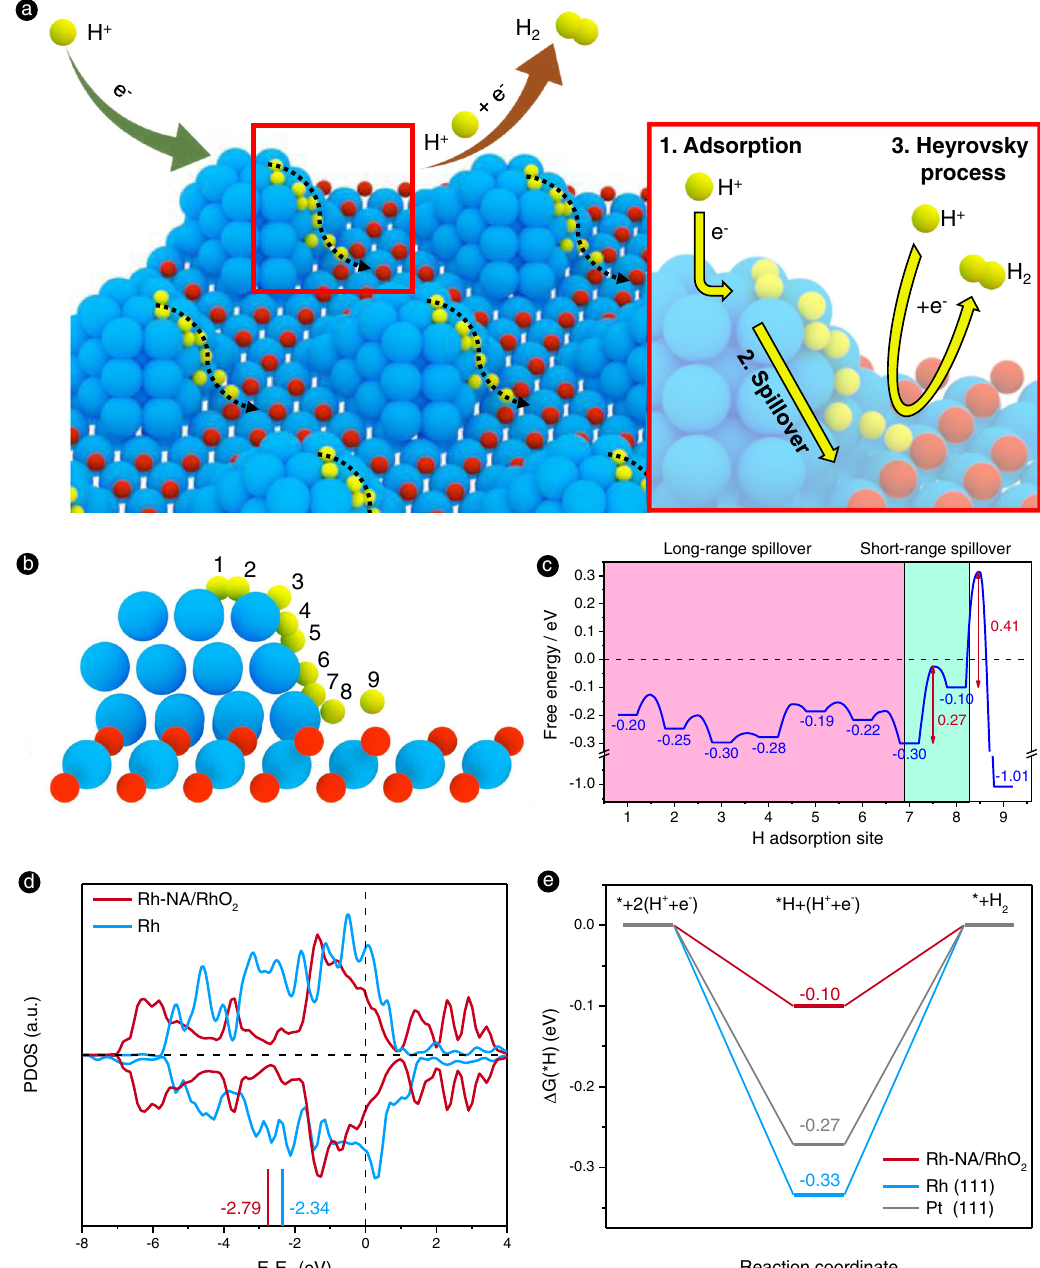
Fig. 4 | Schematic of hydrogen spillover assisted HER mechanism and DFT calculation of Gibbs free energy evolution. a The schematicrepresentationof hydrogenspillover assisted HER mechanismforRh-NA/RhO 2 electrocatalyst. Theenlarge image shows that the HER processinRh-NA/RhO 2 system includes three mainsteps:(i) adsorptionand reduction ofhydrogenonthe Rh nano- particles surface;(ii)the hydrogenspillover from Rh nanoparticlesto the